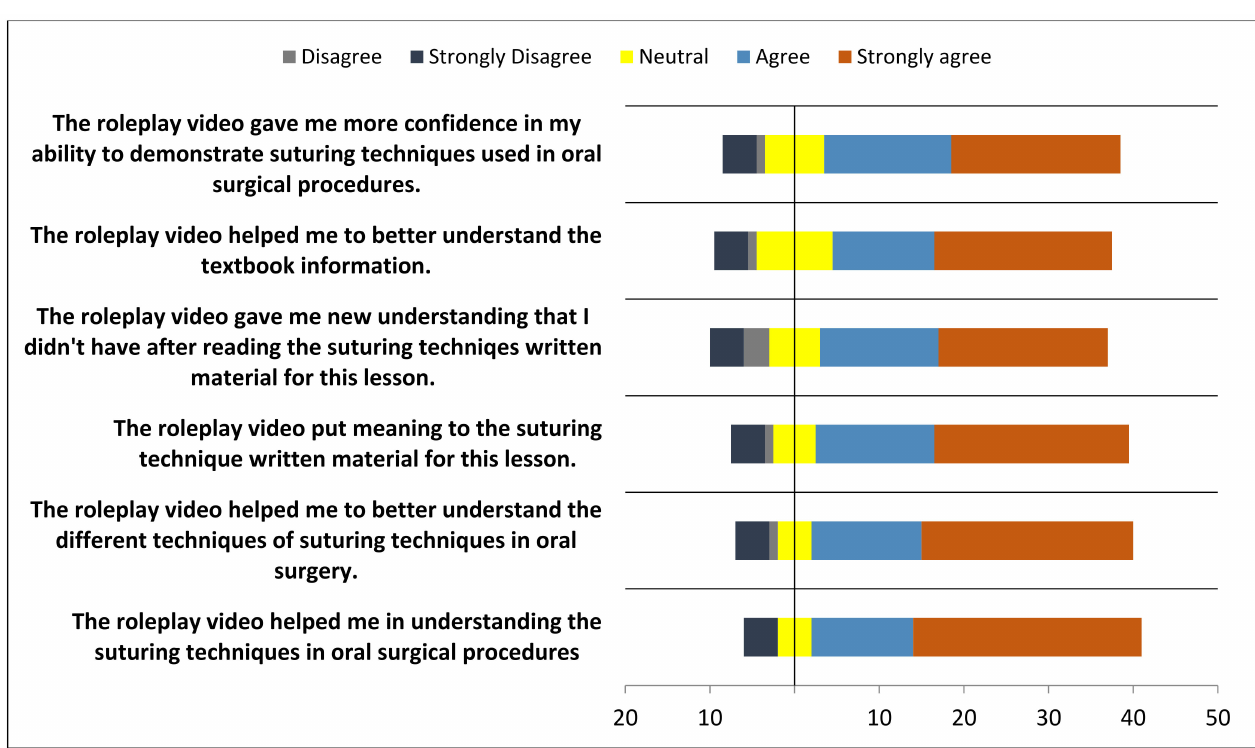
Figure 1. Responses of the participants towards roleplay soft skills in Oral Surgery